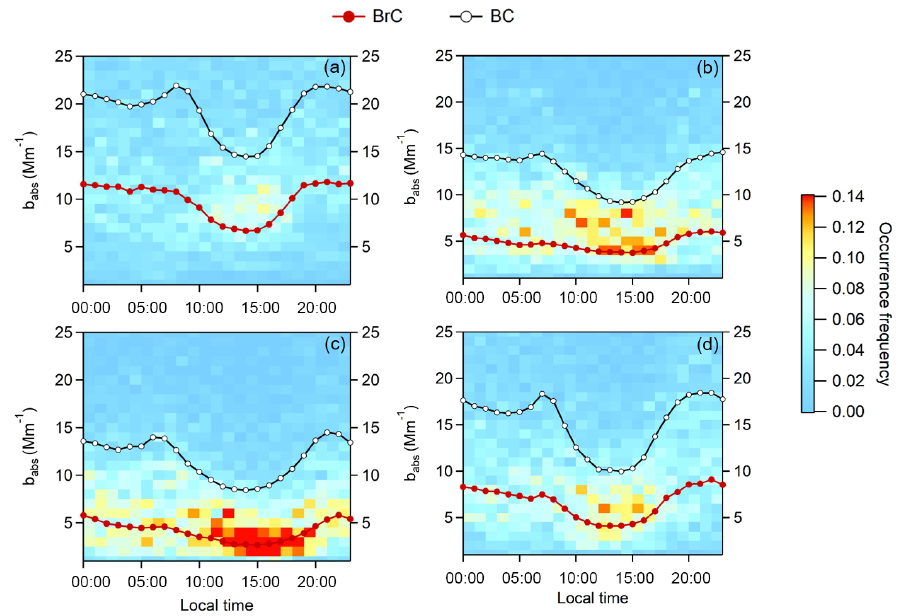
Figure 6. Diurnal variations of b abs_BrC and b abs_BC in the four seasons of (a) winter, (b) spring, (c) summer, and (d) autumn, respectively. The plots show the occurrence frequencies of b abs_BrC in each b abs_BrC bin. The dark red and black circle lines represent the hourly mean b abs_BrC and b abs_BC ,